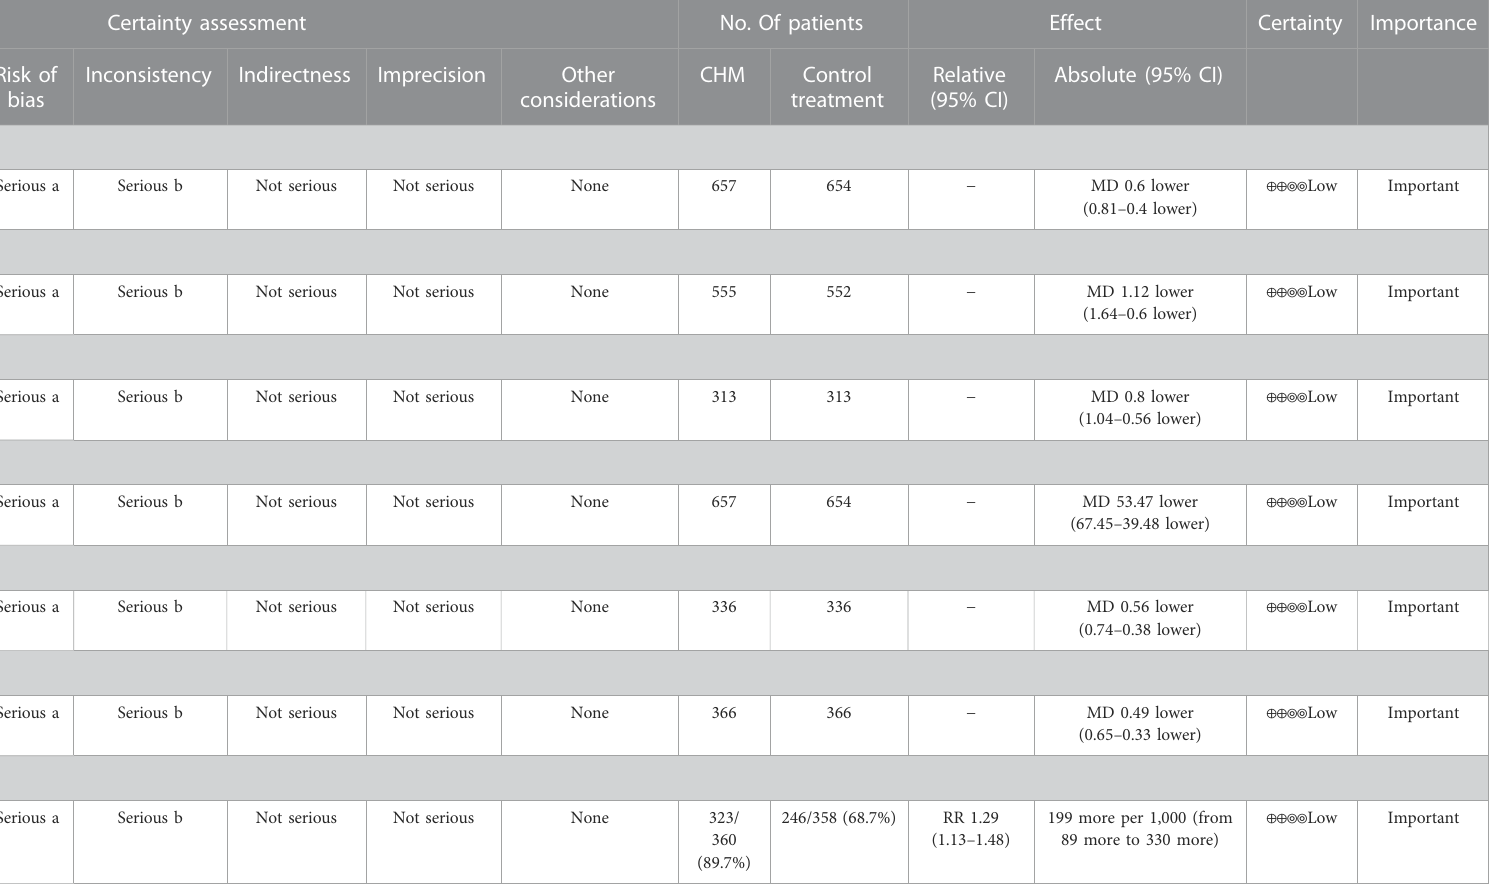
TABLE 3 Certainty of evidence: CHM compared to control treatment for T2DM with